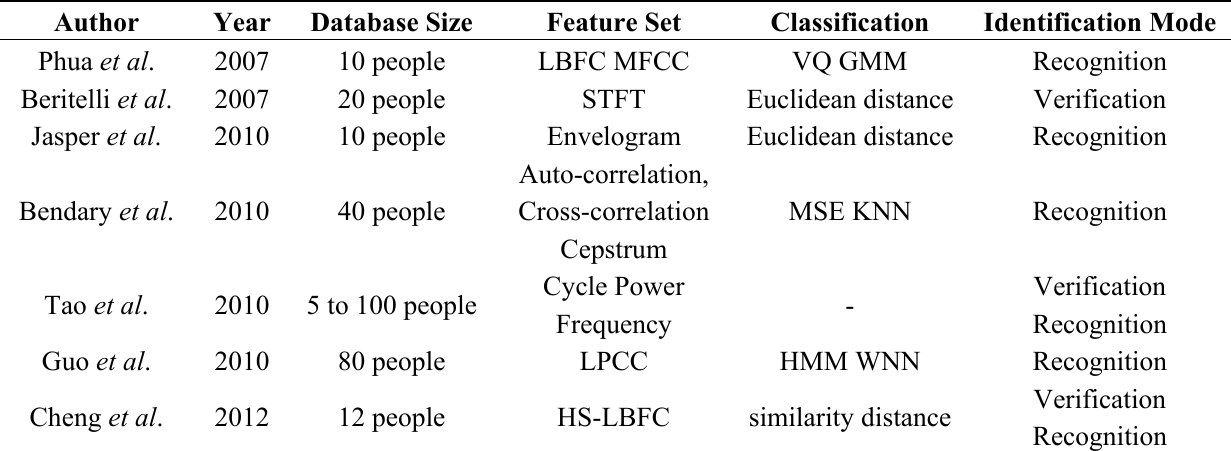
Table 2. Primary studies on heart sound